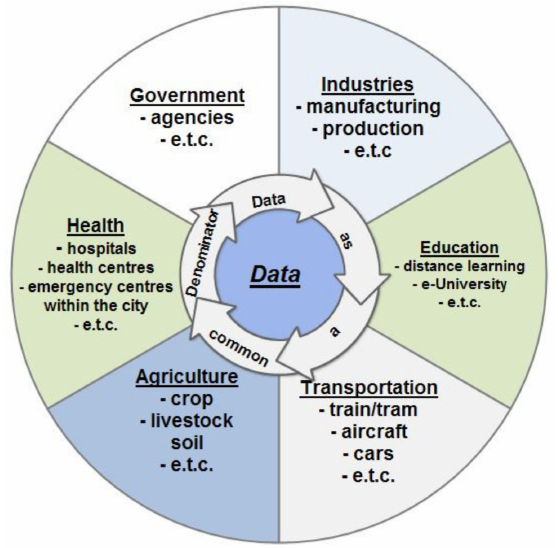
Figure 3. Data as a common denominator and possible integrator with sundry